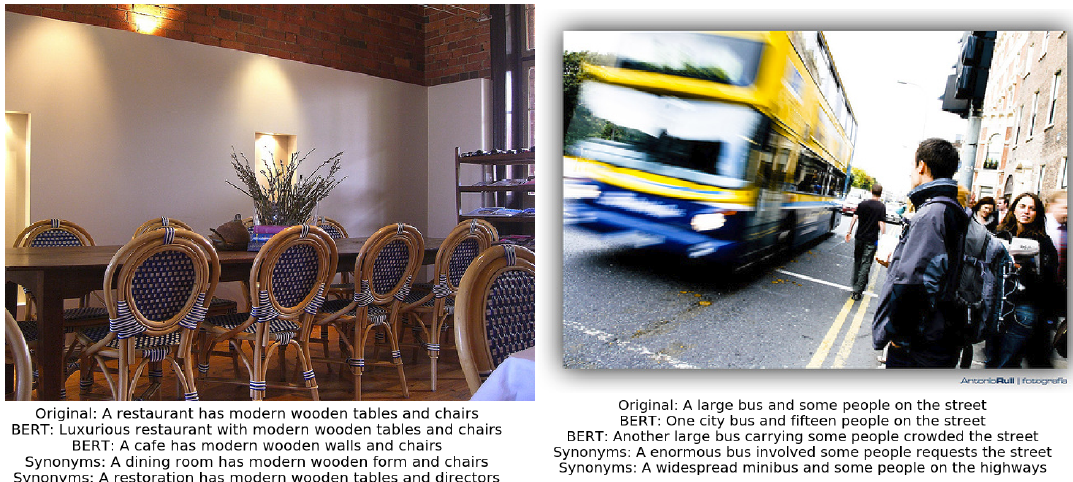
Figure 5. Examples of proposed captions